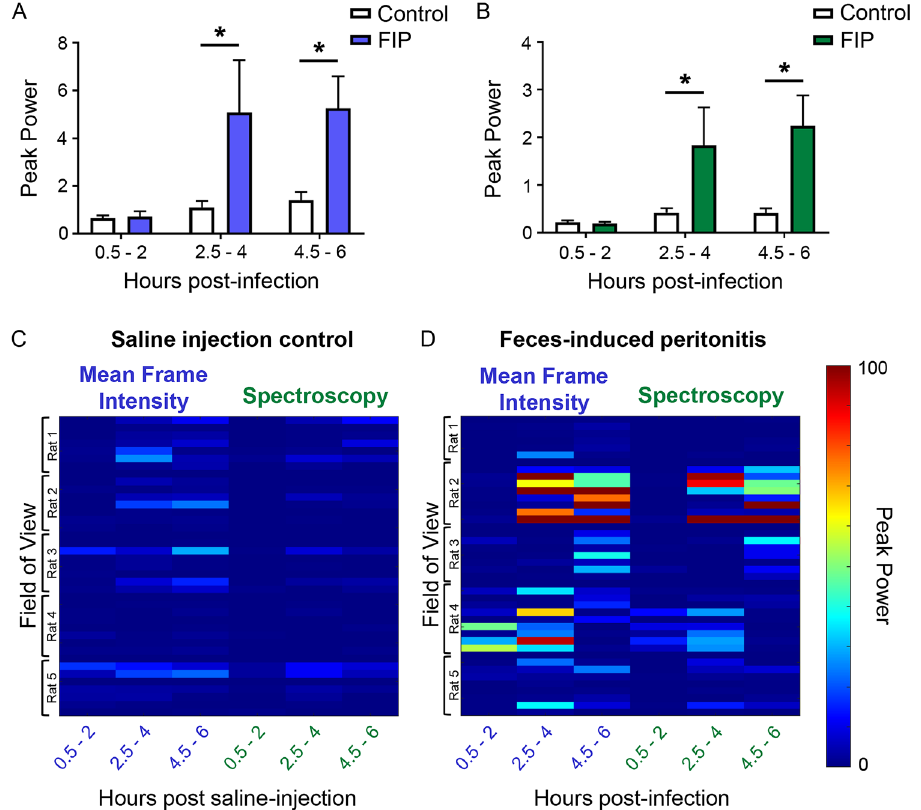
Figure 7. The Power of low-frequency oscillations in microvascular hemoglobin content is increased in skeletal muscle of rats with feces-induced peritonitis. Summary data show change in Power (amplitude 2 ) of low-frequency oscillations in hemoglobin derived from mean frame intensity of intravital microscopy videos ( A ) and continuous wave spectroscopy measurements ( B ) recorded over 6 h after injection of normal saline or feces-induced peritonitis (FIP). Data are presented as mean (SEM) and assessed using two-way ANOVA with Bonferroni correction, n = 5 rats with approximately 8 fields of view/rat, * P < 0.05 compared with control. Heat maps for control ( C ) and FIP group ( D ) show the Power of low-frequency oscillations for each field of view resampled over the three imaging